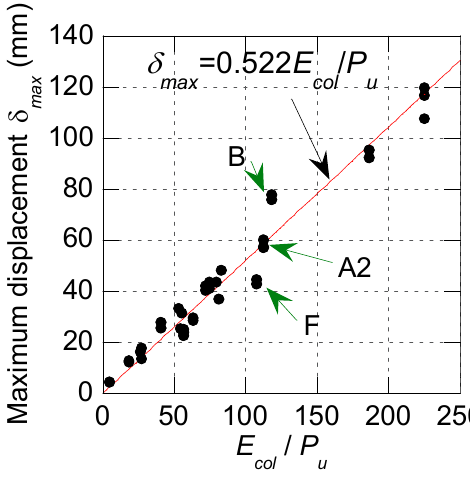
Fig. 13. Relationship between the mean impact force and the static ultimate bending capacity. Fig. 14. Relationship between the ratio kinetic energy to ultimate bending capacity E col /P u and maximum displacement δ max